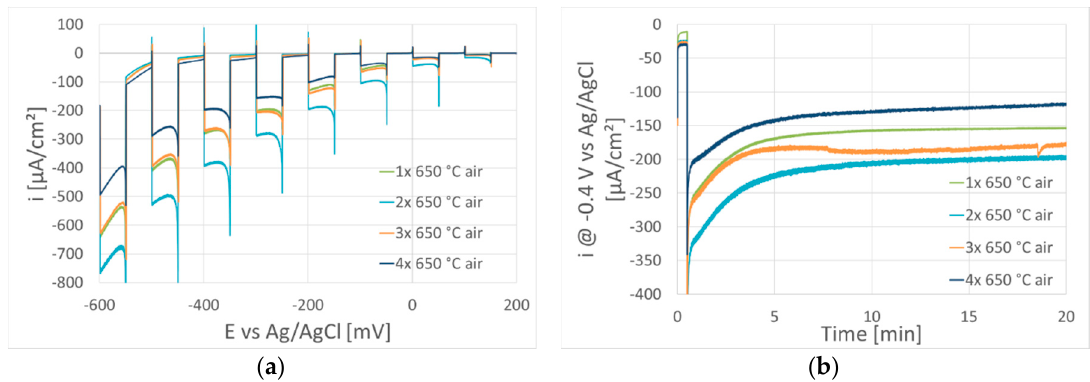
Figure 4. Linear voltammetry ( a ) and chronoamperometry ( b ) of films 1x, 2x, 3x, 4x annealed at 650 °C in air for 3 h.